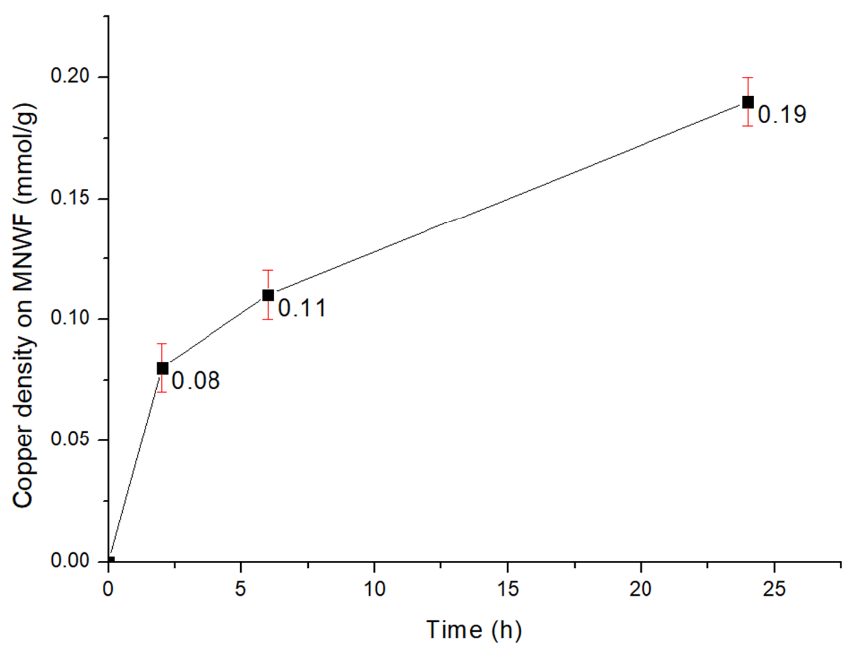
Figure 7. Change in copper ion immobilization amount over time (dg 30% 4-AMP MNWF).